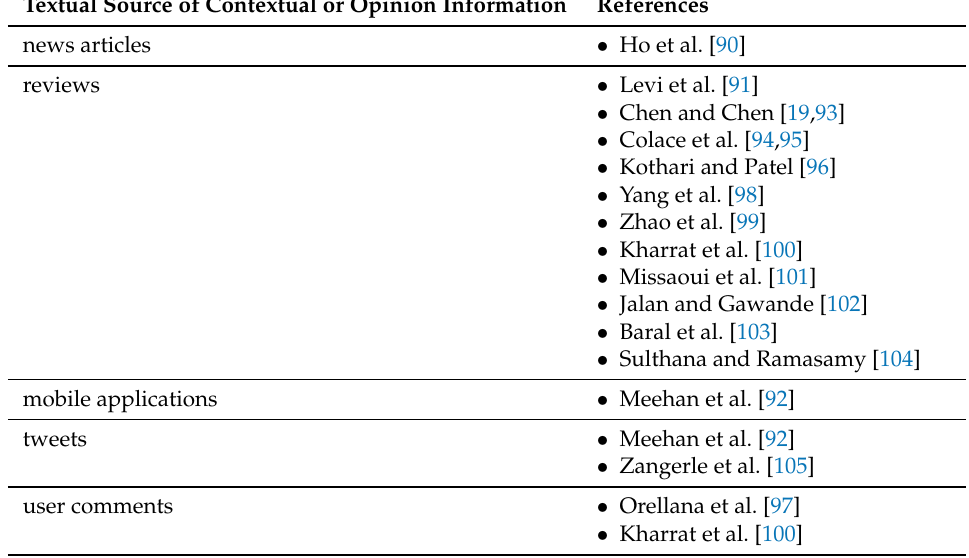
Table 4. Answers for the research questions related to textual sources of contextual and opinion information (question